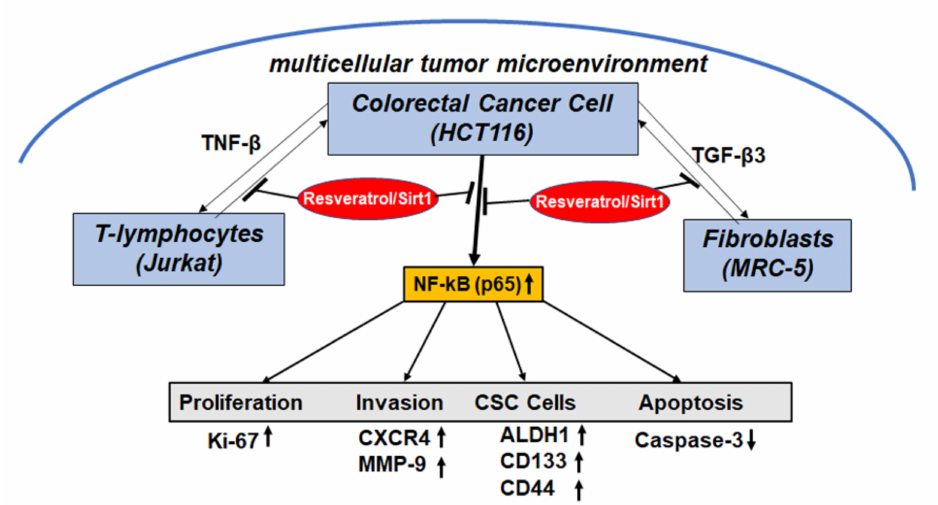
Figure 8. Multitargeting impacts of resveratrol on the malignancy of CRC cells in the